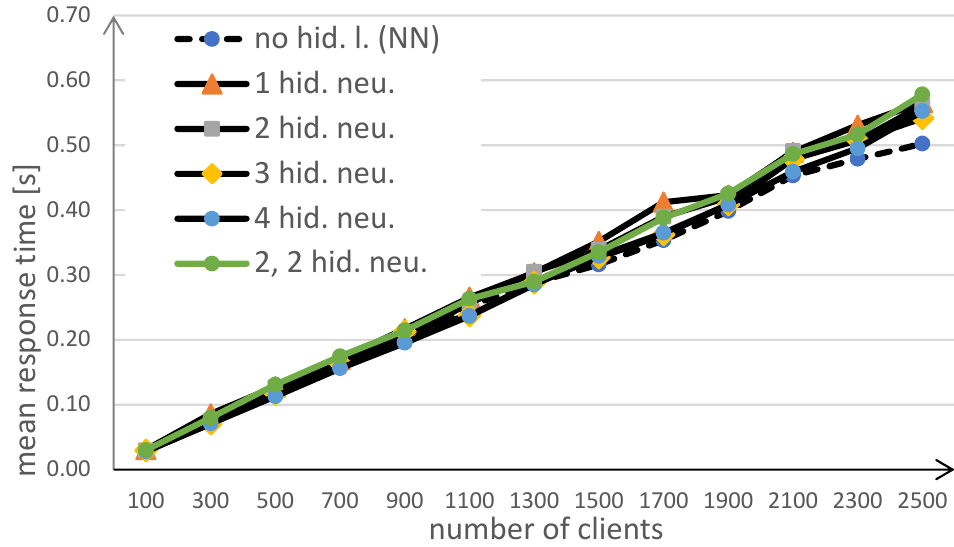
Figure 13. Comparison of the results for modified neural networks.